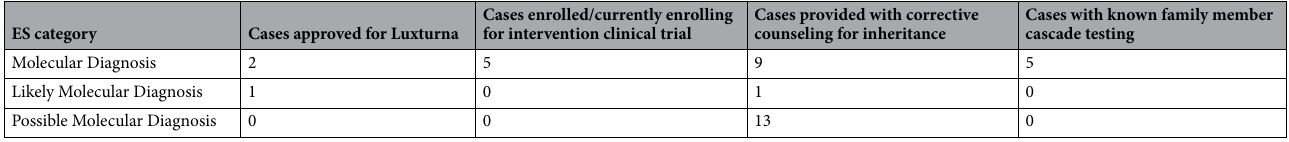
Table 4. Outcomes for ophthalmic